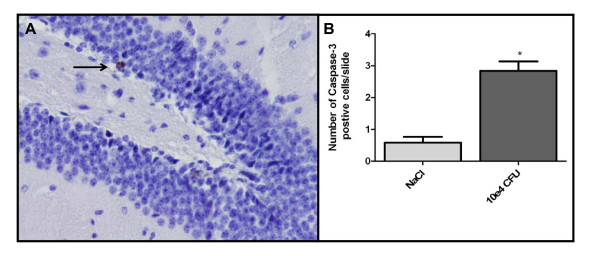
Neuronal apoptosis. Caspase-3 immunohistochemistry of 10 μm sections of the middle portion of the hippocampus of the right cerebral hemisphere of mice inoculated with 104 CFU S. pneumoniae at 30 hrs post infection (panel A; 200× magnification). Mice inoculated with S. pneumoniae showed significantly more hippocampal apoptosis at 30 hrs post infection than NaCl infected control mice (panel B, expressed in mean number of Caspase-3 positive cells/section +/- S.E.M.; groups were compared using a Student's t-test; *P < 0.001).